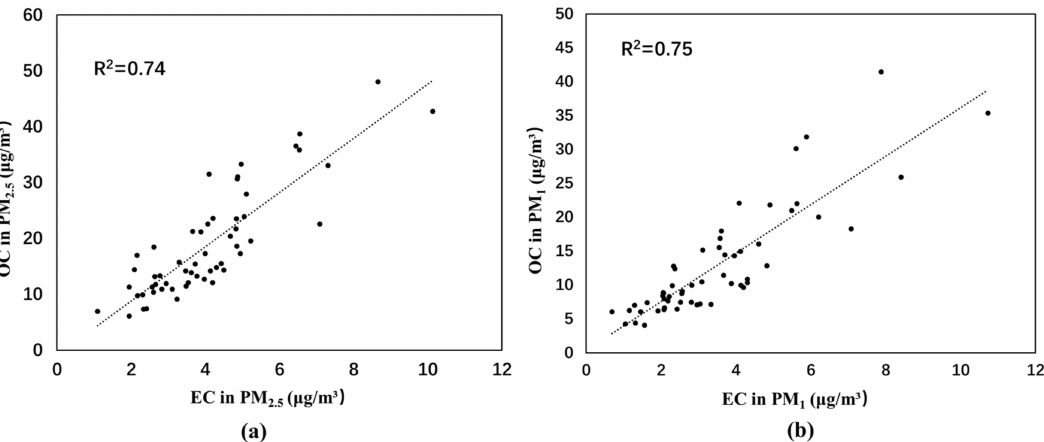
Figure 5. The relationship between OC and EC in PM 2.5 ( a ) and PM 1 ( b ) in Handan in the period from 15 October to